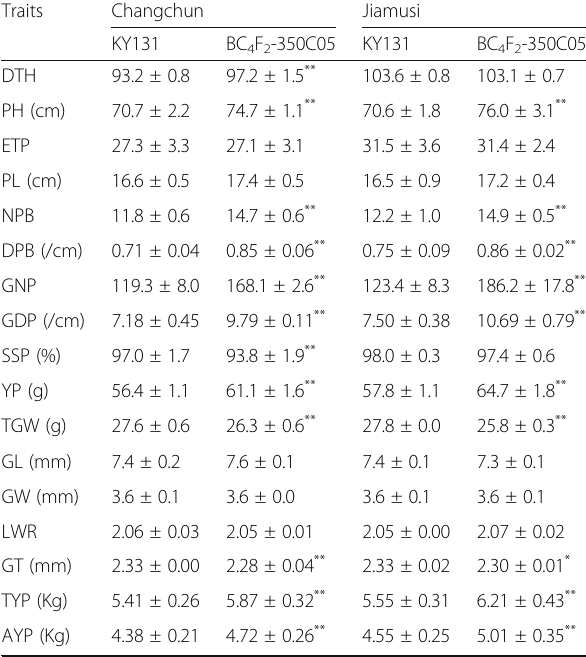
Table 4 Agronomic performance of Kongyu 131 and its improved line BC 4 F 2 -350C05 at two locations